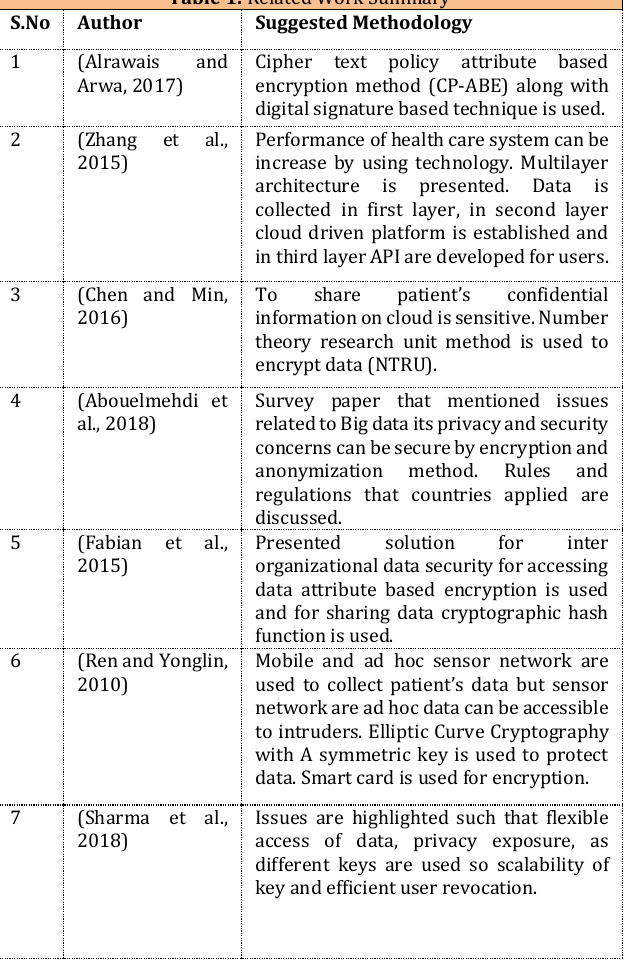
Table 1: Related Work Summary S.No